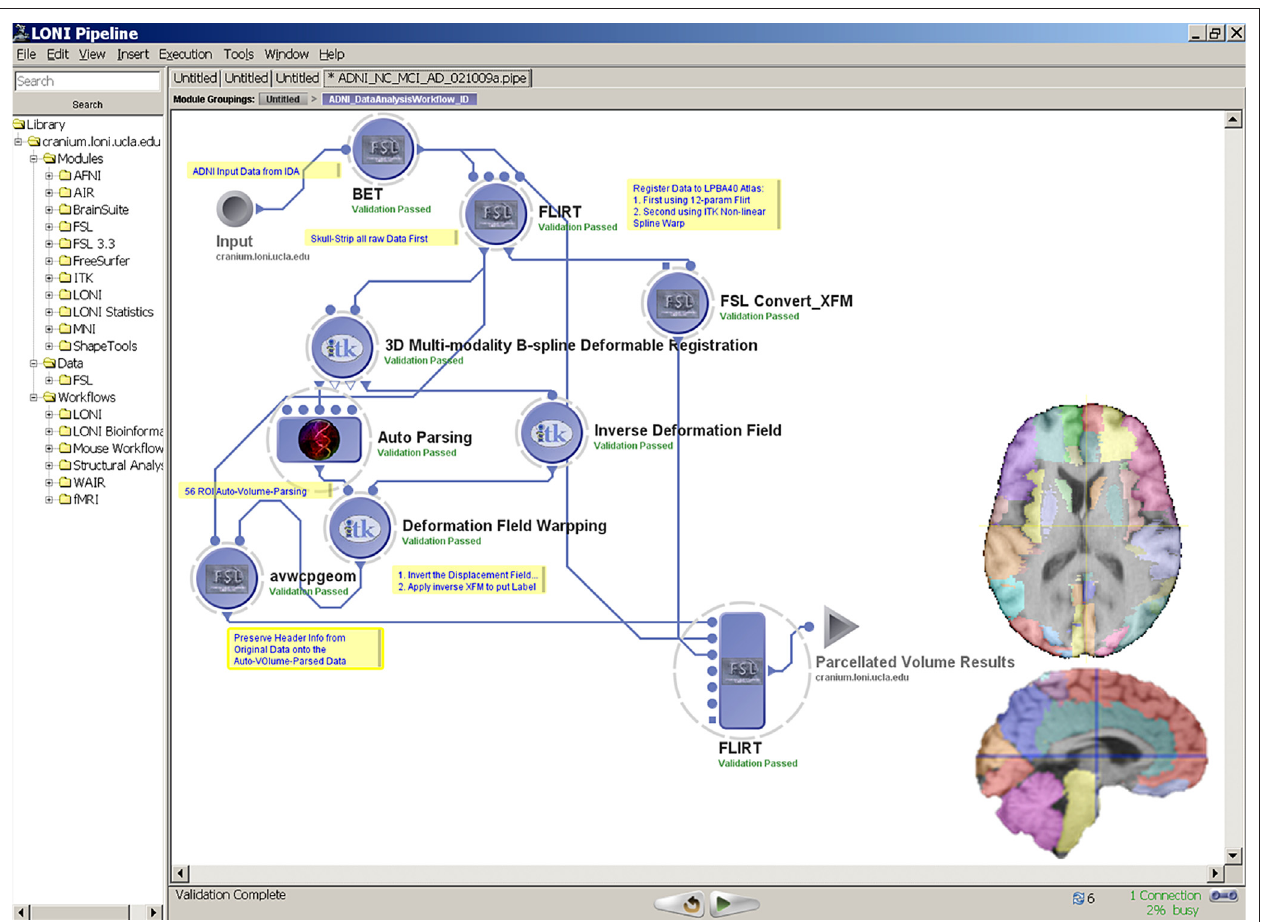
FIGURE 2 | Using a robust executable entitled Brain Parser (Tu et al., 2008 ), LONI Pipeline can be used to extract 56 predefi ned ROI masks from any input brain image volume